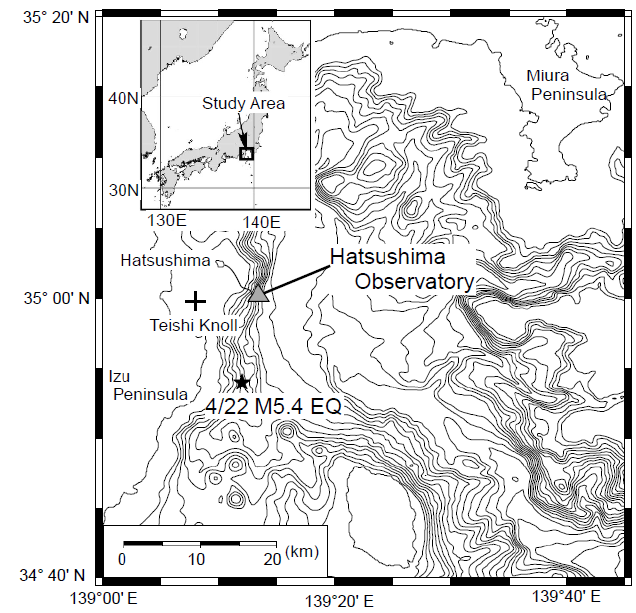
Figure 1. Location of the Hatsushima Observatory. A star shows the epicenter of the off-Izu Peninsula earthquake that occurred on 22 April 2006. Teishi Knoll is a submarine volcano that erupted in